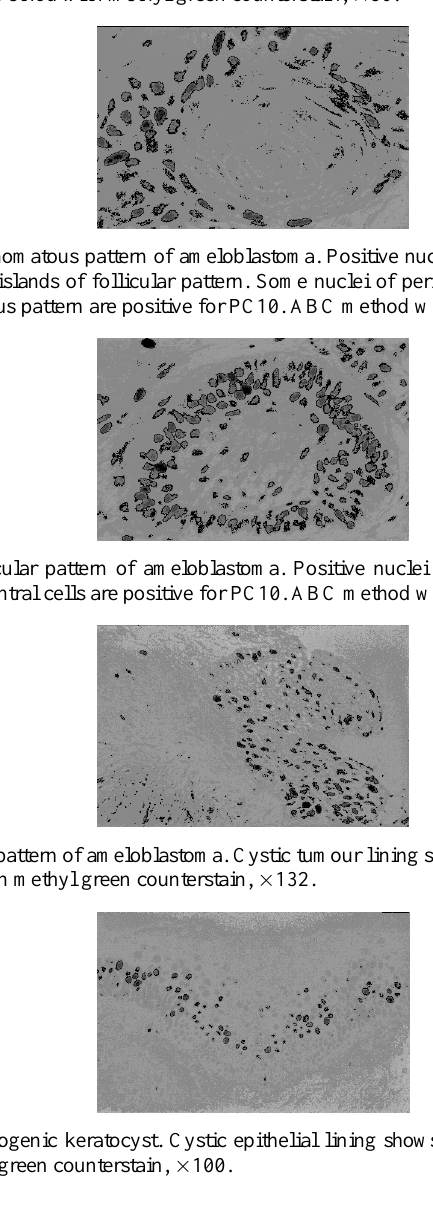
Fig. 1. PCNA expression in plexiform pattern of ameloblastoma. Positive nuclei for PC10 are less numerous in the central areas than in the peripheral layer. ABC method with methyl green counterstain, × 50.